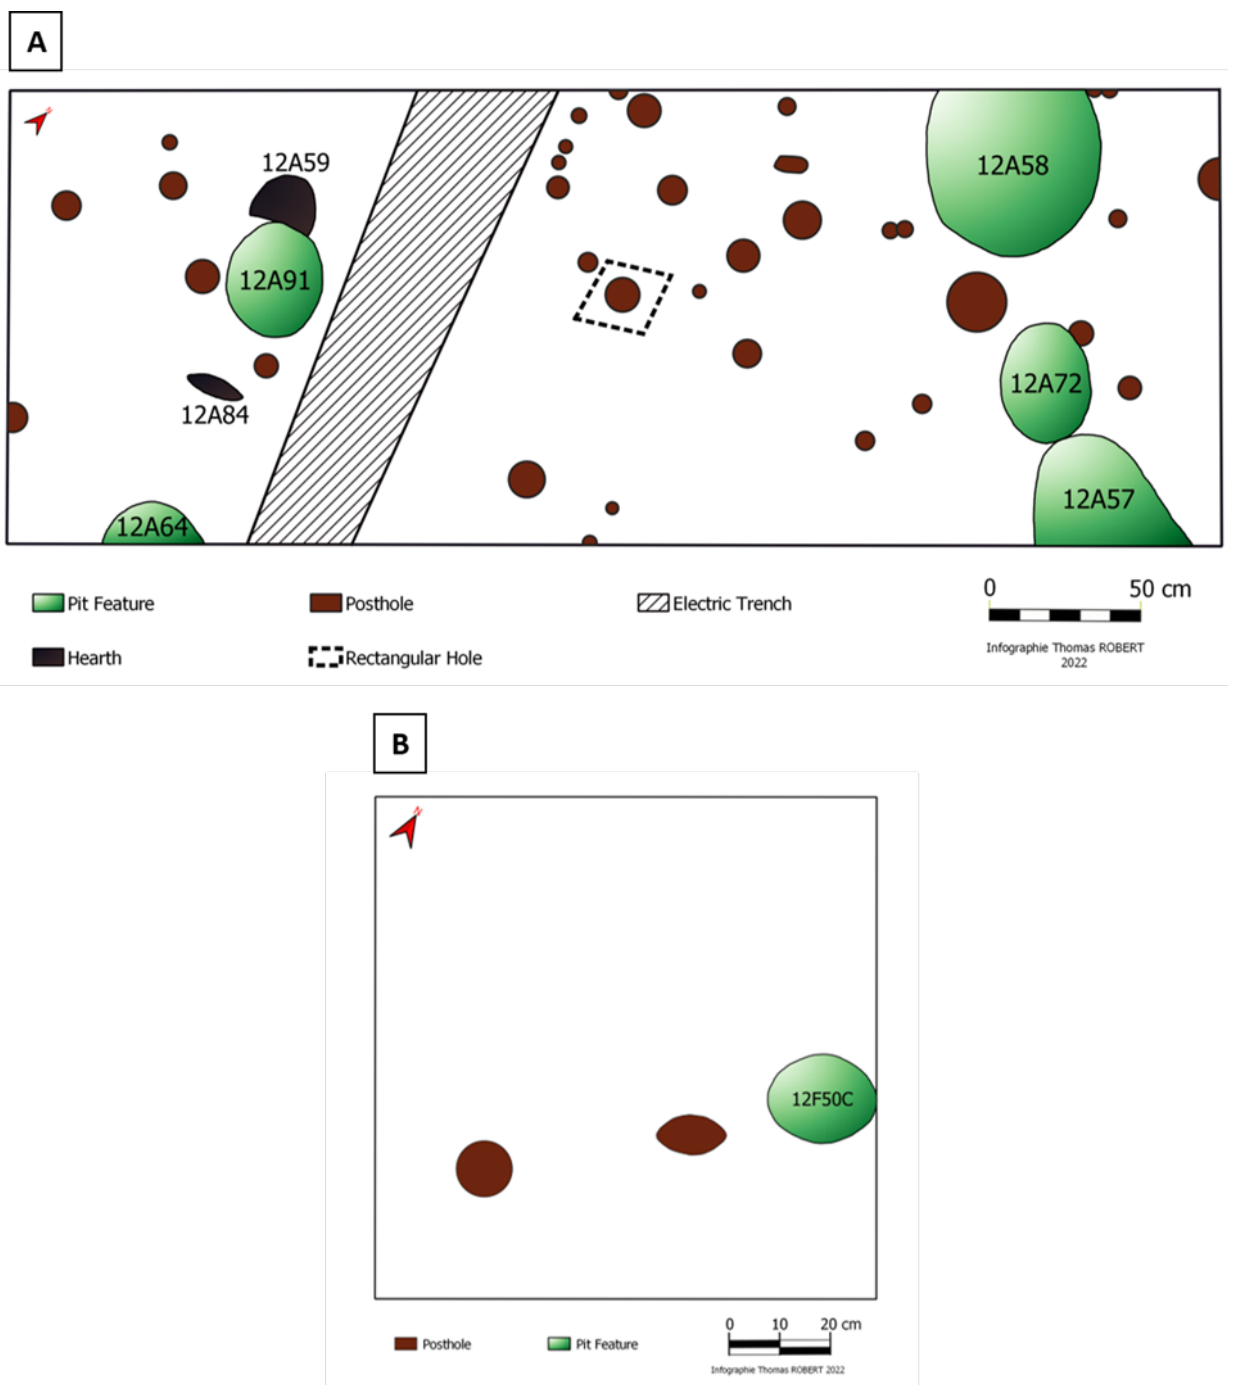
Figure 2. Locations of the archaeological features found in areas 12A ( A ) and 12F ( B ) at the Fort Odanak site (CaFe-7) (T. Robert, 2022).